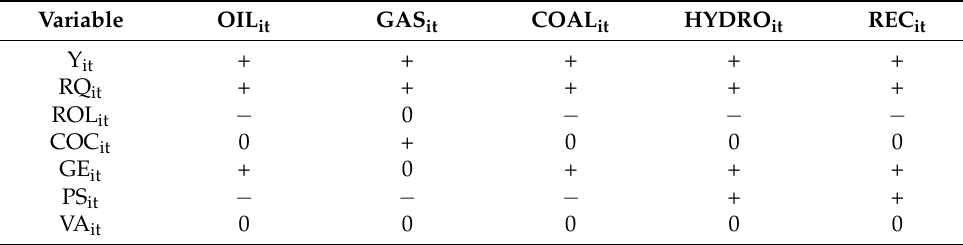
Table 6. Matrix of the